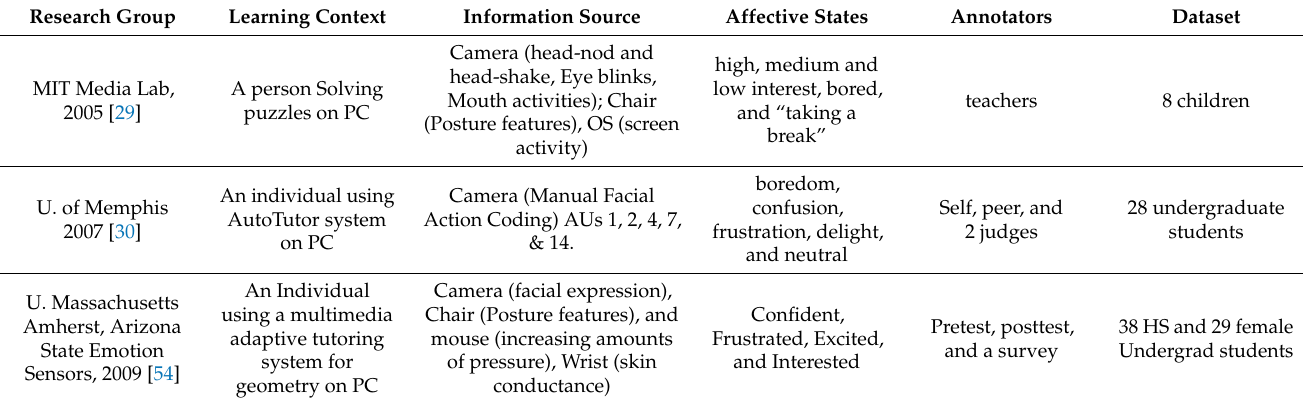
Table 3. Comparison of motivating literature frameworks